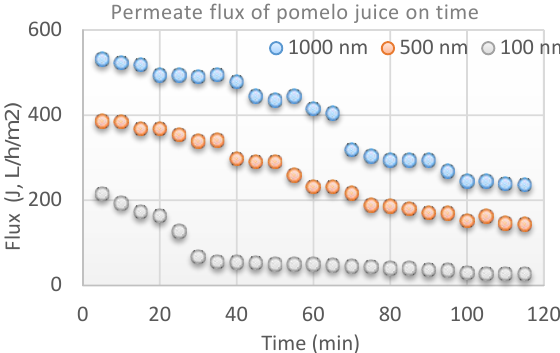
Figure 4. Permeate flux of pomelo juice on time with different membrane pore sizes ( T = 30 °C; TMP = 2 bars).